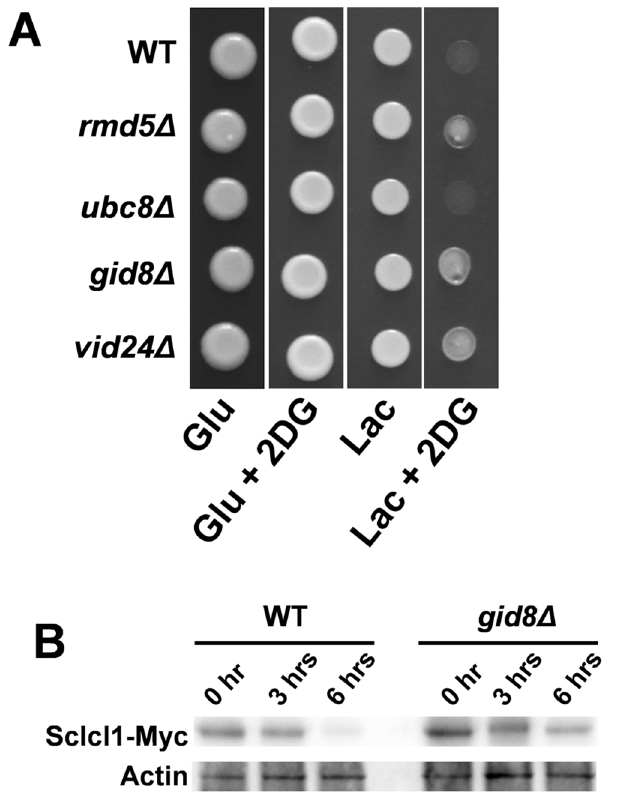
Fig 8. Inactivation of the GID complex in S . cerevisiae inhibits catabolite inactivation. (A) S . cerevisiae strains were pre-grown in YNB-lactate and spotted on SC medium with glucose (Glu) or lactate (Lac) in the presence or absence of 2-deoxyglucose (2DG): WT, DCY33; rmd5 Δ , DCY34; ubc8 Δ , DCY35; gid8 Δ , DCY36; vid24 Δ , DCY37 (S2 Table in the supplementary information). (B) Western blot of wild-type (DCY134) and gid8 Δ cells (DCY130) expressing ScIcl1-Myc 9 . Cells were pre-grown in YNB-lactate, exposed to glucose, and protein extracts prepared at the indicated times. Protein extracts were subjected to western blotting, and the same membranes probed for the Myc 9 epitope and then for actin as an internal loading control. Similar data were obtained in two independent replicate